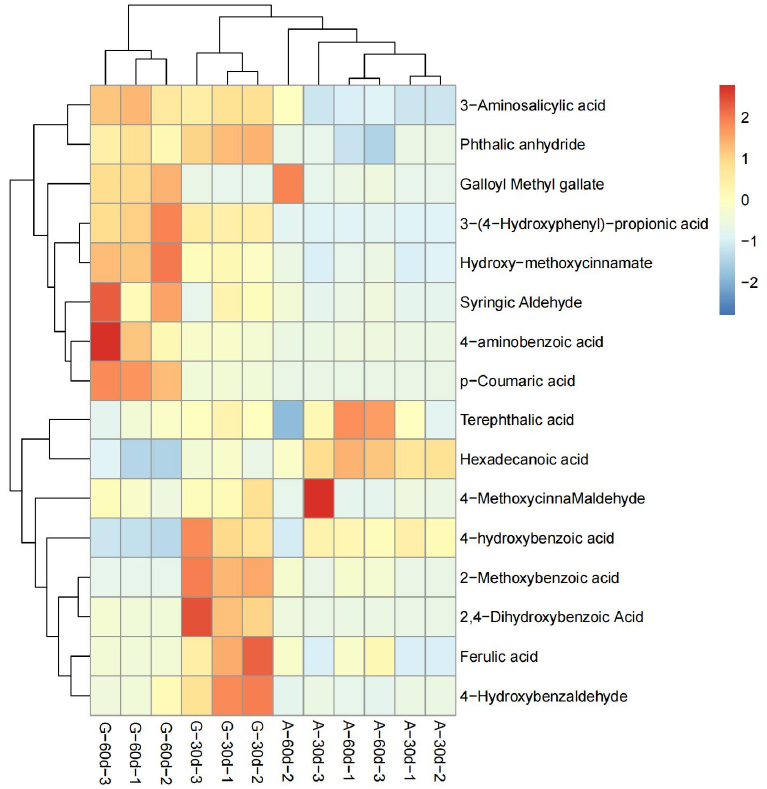
Figure 5. Clustering analysis diagram of DEMs related to phenolic acids between A. correntina and GH85.